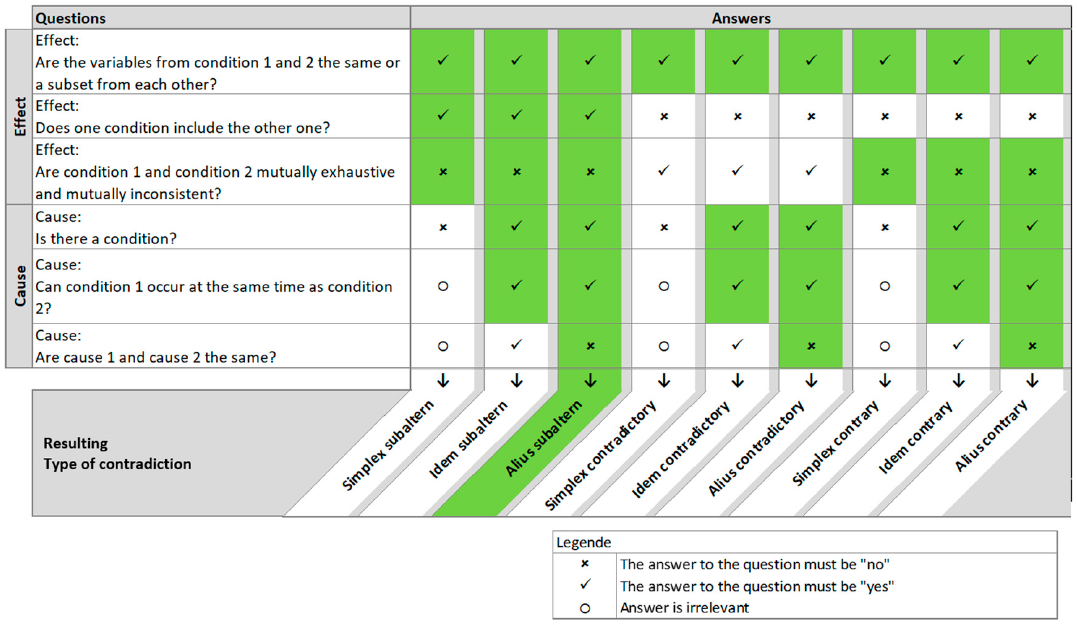
Figure 9. Process for Alius Subaltern.